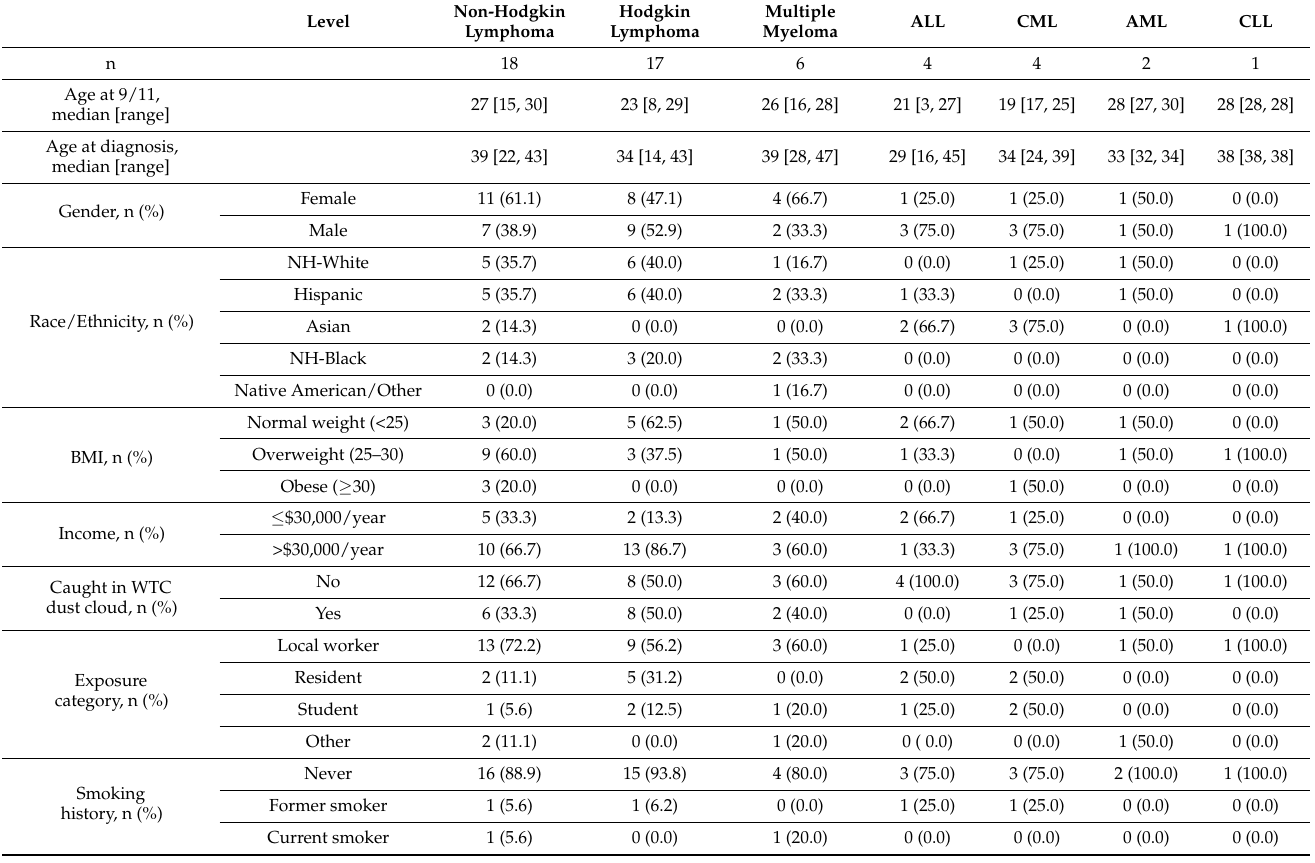
Table 3. Characteristics of EYA diagnosed with hematologic cancers included in the WTC EHC cancer analysis.